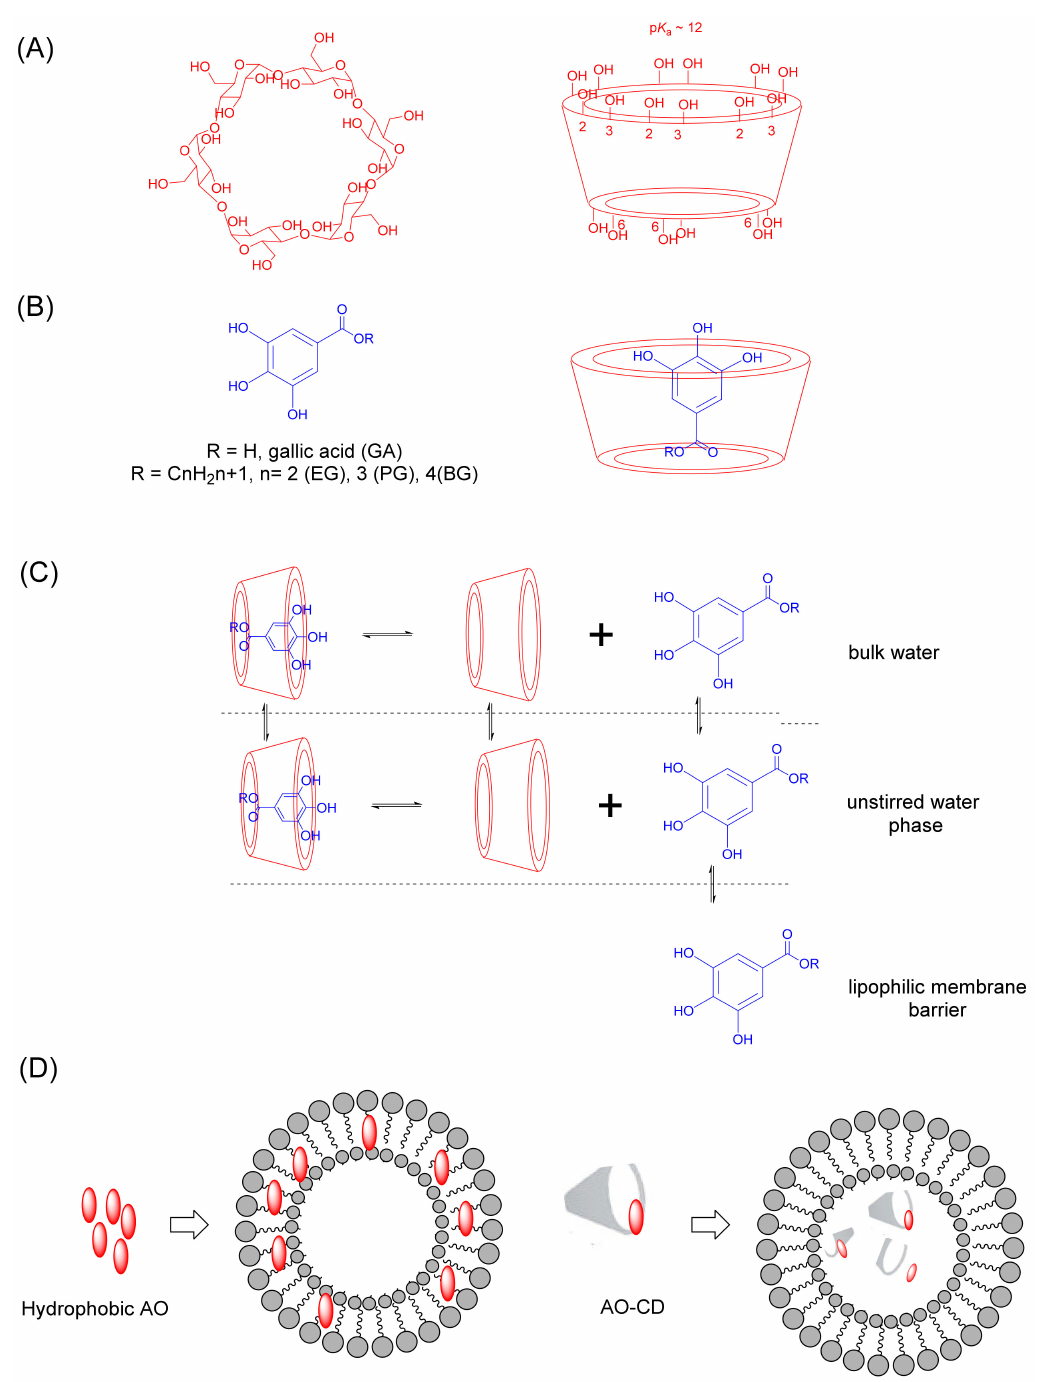
Figure 4. ( A ) Schematic representation of chemical structure of CDs, showing primary and secondary -OH groups and their conformation (truncate shape). ( B ) Inclusion complex for gallates (stoichiometry 1:1) with the phenolic ring inserted into the CD cavity and the -OH groups pointing outwards. ( C ) Representation of potential distributions of a free hydrophilic CD, gallates, and a gallates–CD complex between bulk water, unstirred water, and membrane. Gallates–CD complex formation can enchance gallates diffusion through the unstirred water phase and, consequently, their membrane permeation (adapted from reference [169]. ( D ) Schematic representation of potential localization of a free AO and AO − CD complex in